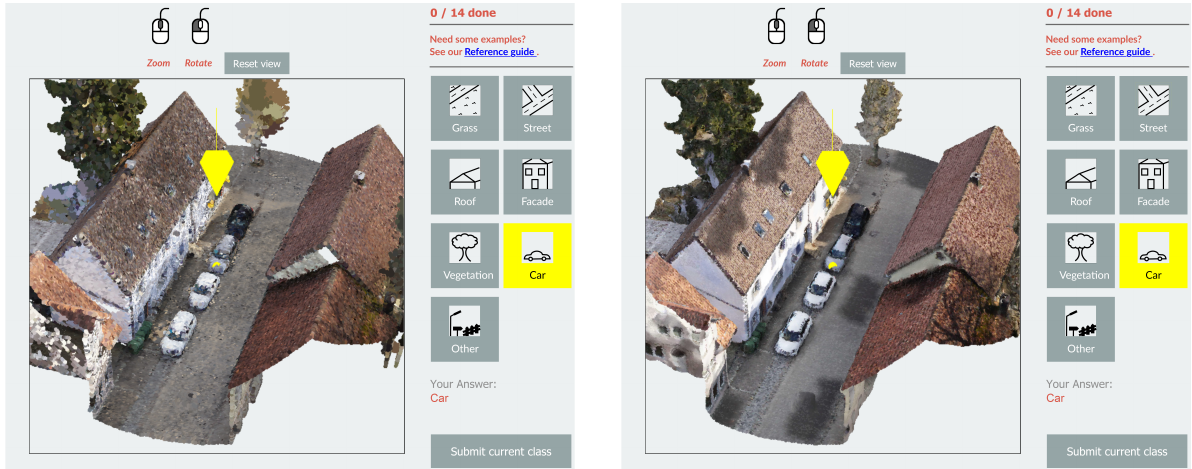
Figure 2. Webtool used by crowdworkers for labeling a selected point. Either the colorized point cloud ( left ) or the textured mesh ( right ) is presented to the crowd (please note that class designations were simplified for